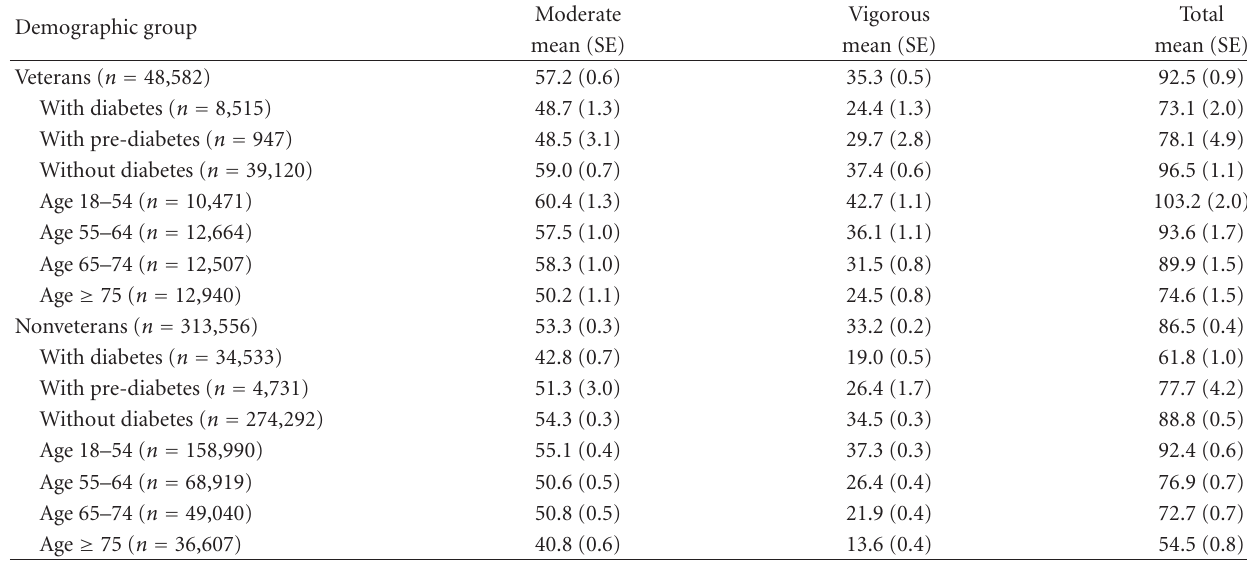
Table 2: Mean minutes of moderate, vigorous, and total physical activity in an average week reported by veterans and nonveterans with and without diabetes in the United States, 2009 Behavioral Risk Factor Surveillance